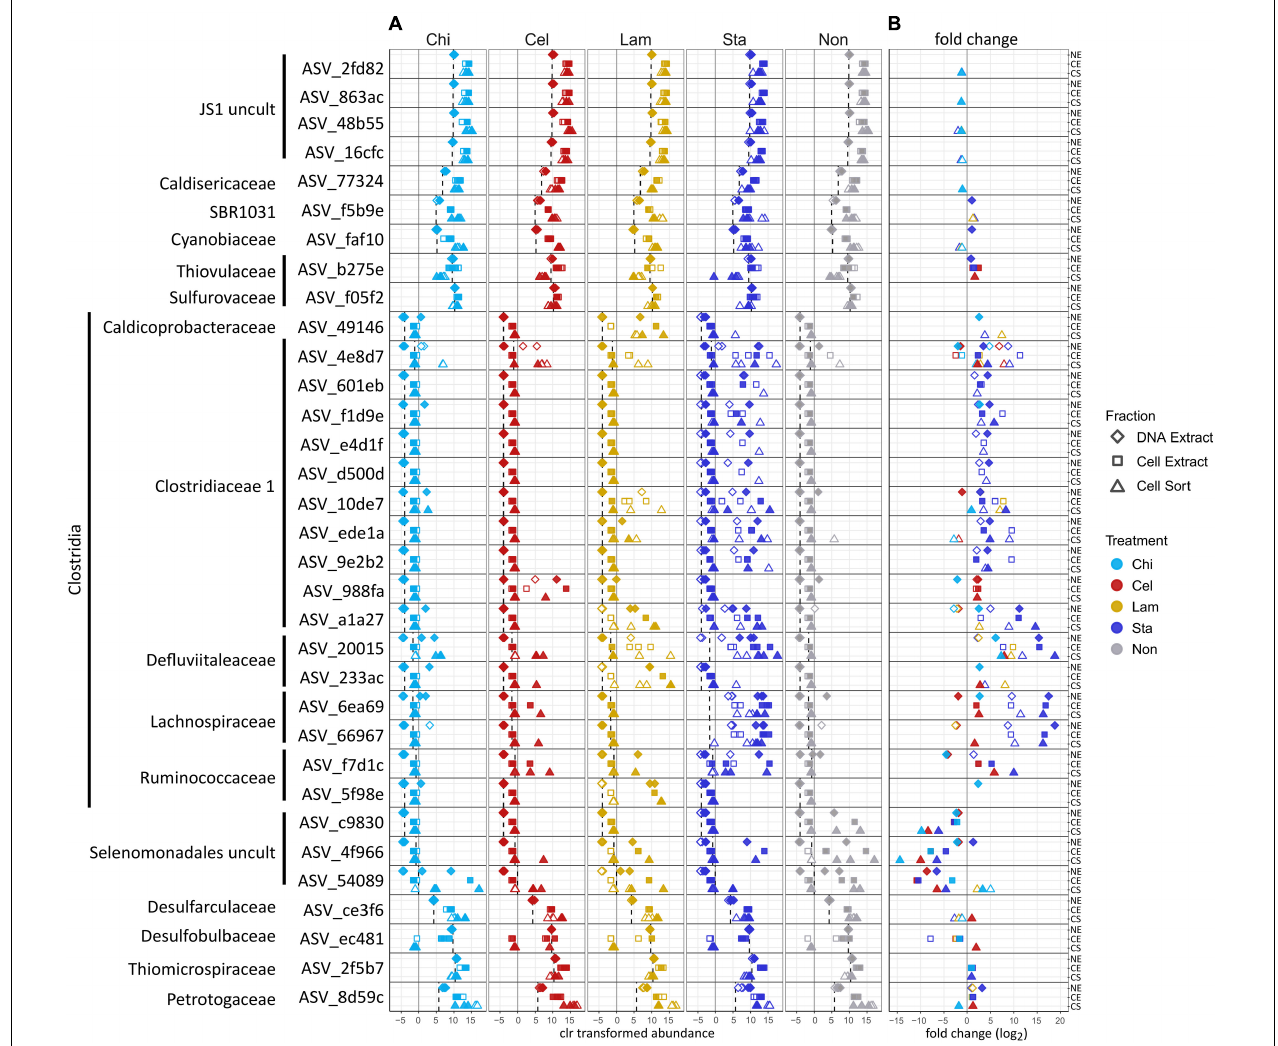
FIGURE 3 | Effect of polysaccharide amendment on abundant ASVs (i.e., occurring with > 3% relative sequence abundance in at least one sample). Center log ratio (clr) transformed abundance of ASVs (A) . Note that clr values indicate abundance of an ASV as relative to the mean abundance of all ASVs in a sample with positive clr values indicating abundance greater than the mean abundance. Dashed line: mean clr transformed abundance of an ASV in the environmental sample (inoculum, day 0). Log 2 fold changes > 1 between no amendment and each substrate treatment for each ASV (B) . Gray line represents a fold change of 0 (i.e., no difference between no amendment and substrate amendment). No data are available for Lam at day 5 as replicate C was lost and analysis relied on triplicate samples. Diamonds: DNA extract, squares: cell extract, triangles: cell sort, open symbols: day 2, filled symbols: day 5. Cel: cellulose, Chi: chitin, Lam: laminarin, Sta: starch, Non: no